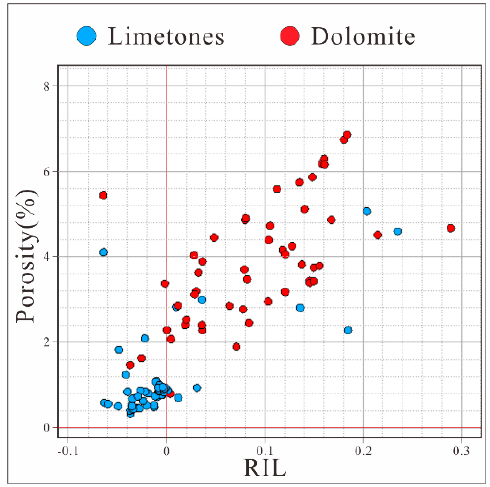
Figure 9. Cross plot of RIL reservoir indicator factor and neutron porosity.